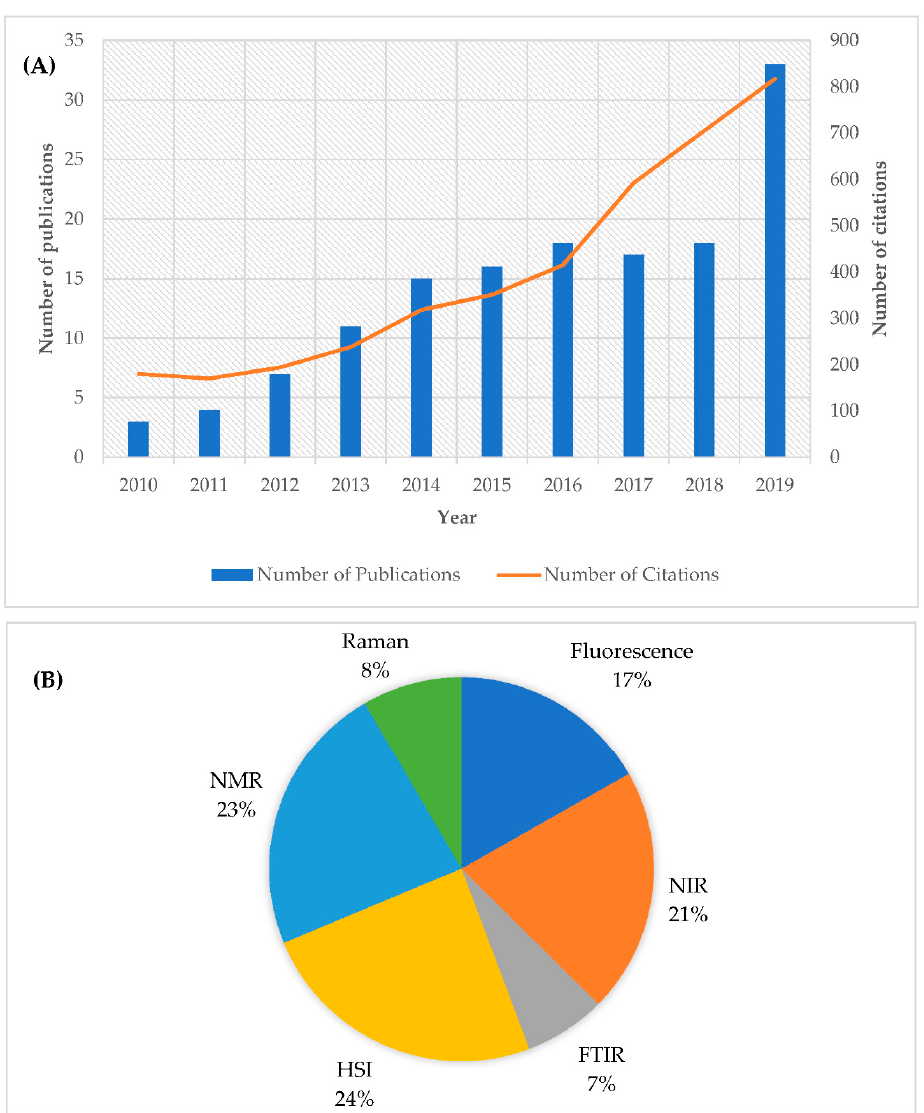
Figure 2. Number of scientific papers and citations ( A ) and publications distributed between the di ff erent spectroscopic techniques ( B ) used for detecting freshness or frozen–thawed fish or other seafoods. NMR; nuclear magnetic resonance, NIR; near infrared, HSI; hyperspectral imaging, FTIR; Fourier-transform infrared spectroscopy. Information obtained from the database Scopus (Search criteria: TITLE-ABS-KEY freshness) OR (frozen–thawed) (freezing) AND (fish) OR (seafood) AND (spectroscopy; Figure A or di ff erent spectroscopic techniques; Figure B). The data were obtained